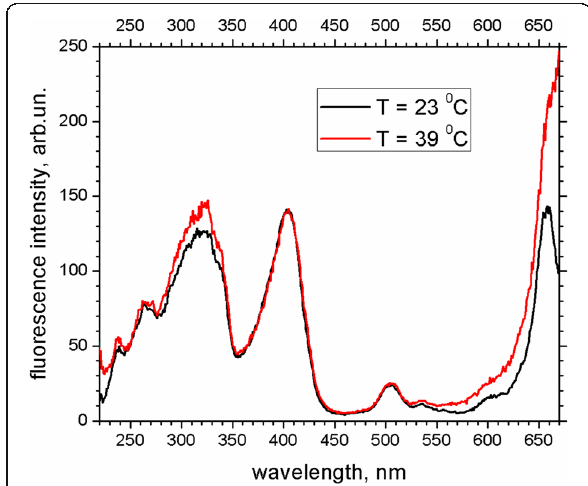
Fig. 8 Fluorescence excitation spectra (normalized at 404 nm) of chlorin e 6 added to PS-PPO-PNIPAM hybrid NS at 23 °C (black line) and at 39 °C (in 14 min after heating was switched on; red line). Emission wavelength 680 nm; 50 mM Tris-HCl buffer, pH 7.2, was used as solvent